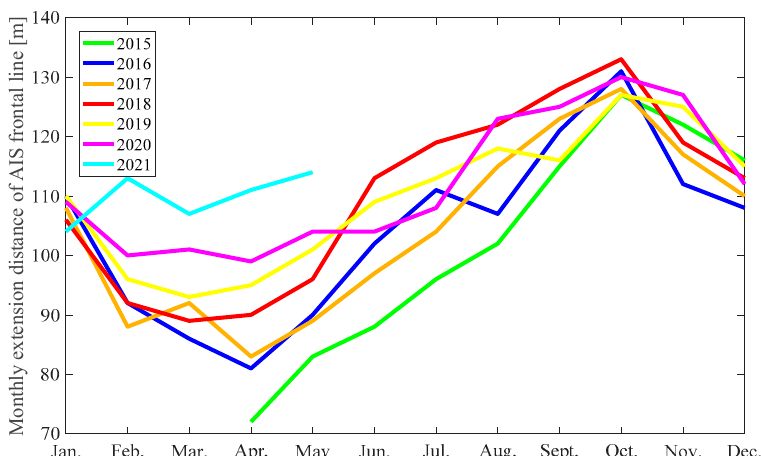
Figure 9. Seasonal advance rate with the expansion distance of the AIS frontal line in Region 3. The monthly average advance rate for each year is color-coded.